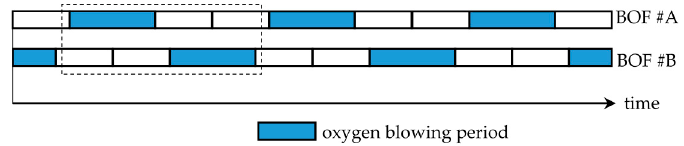
Figure 9. Schematic diagram of alternated operation of BOFs. The shadowed zones denote the oxygen blowing periods. The dashed rectangle denotes a melting cycle.